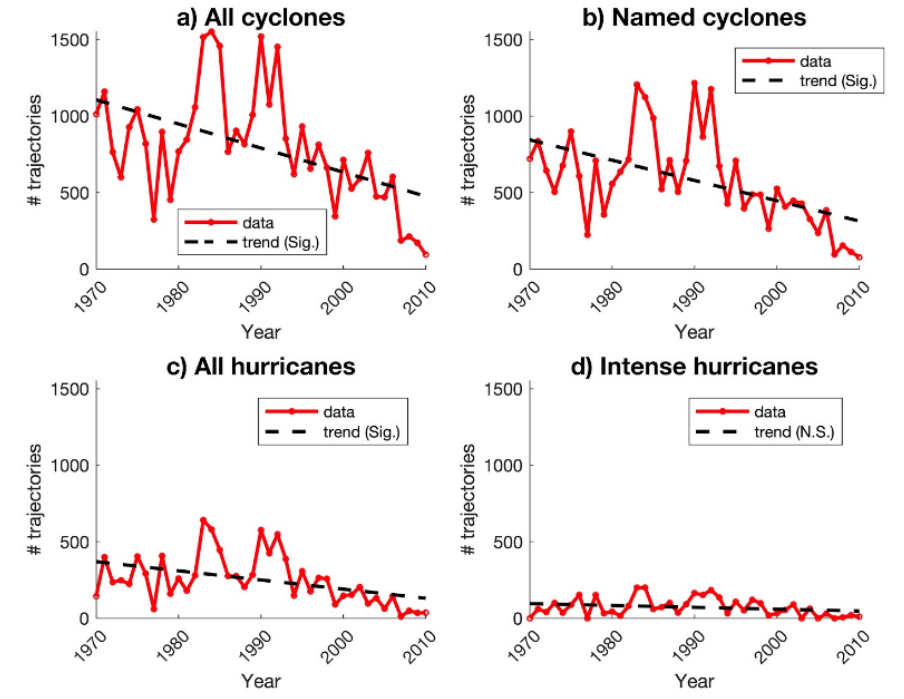
Figure 8. Same as Figure 3, but for a Pacific Ocean box 10 ◦ N to 25 ◦ N and 101 ◦ W to 121 ◦ W. ( a ) All cyclones, ( b ) named cyclones, ( c ) all hurricanes, ( d ) intense